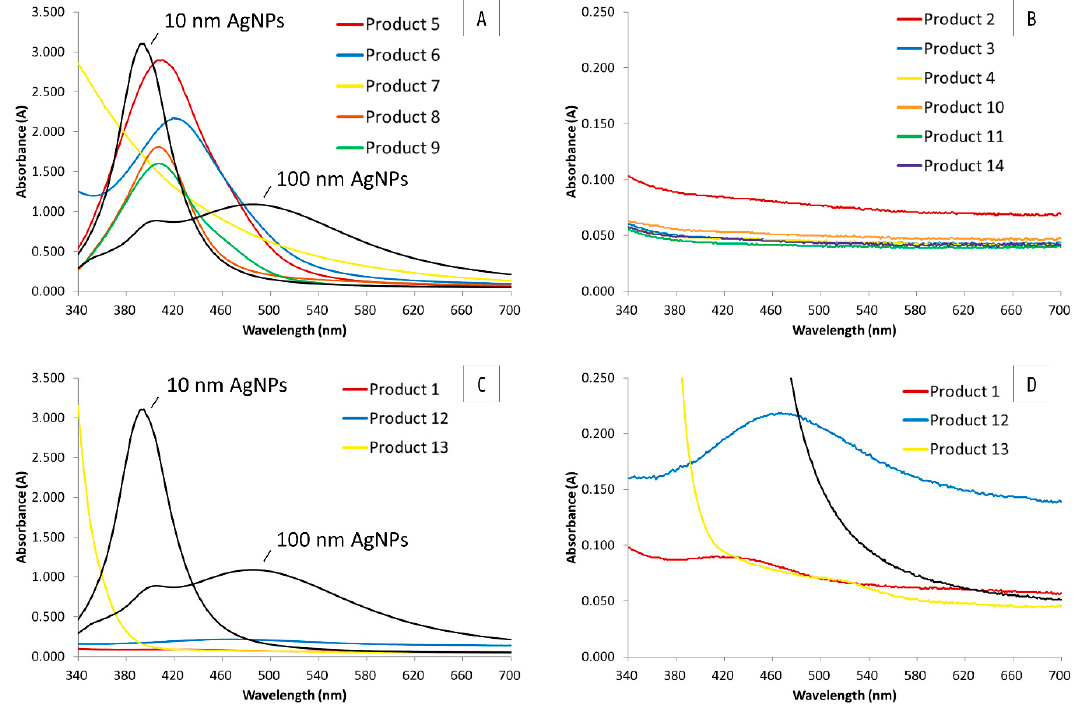
Figure 4. Absorbance spectra of product 5, 6, 7, 8, and 9 ( A ); product 2, 3, 4, 10, 11, and 14 ( B ); and product 1, 12, and 13 ( C,D ) compared with the absorbance spectra of 10 and 100 nm AgNPs of Nanocomposix with a concentration of 20 mg L -1 . Batch 1 is represented for products 5, 6, 8, and 9. Products 5 and 6 were diluted with a 1:10 ratio and products 7 and 8 with a 1:2 ratio, and a 1:20 dilution of product 9 was measured.